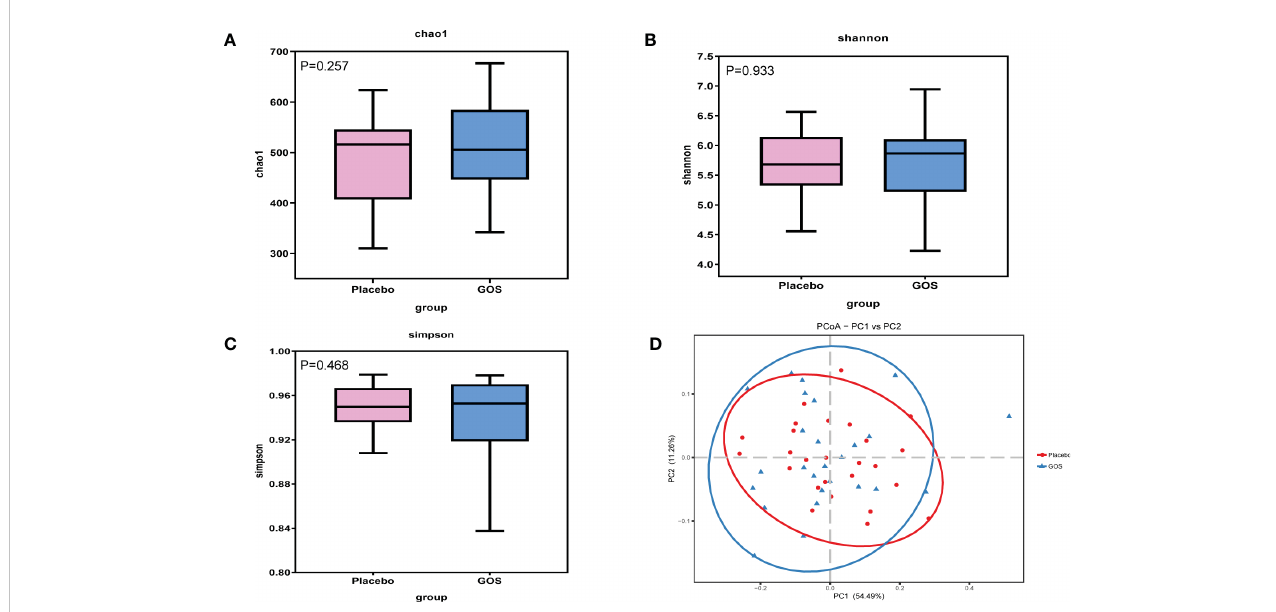
FIGURE 3 Alpha and beta diversity of gut microbiota in placebo and GOS groups. (A) Comparisons of Chao 1 index. (B) Comparisons of Shannon ’ s index. (C) Comparisons of Simpson ’ s index. (D) PCoA calculated based on Weighted unifrac